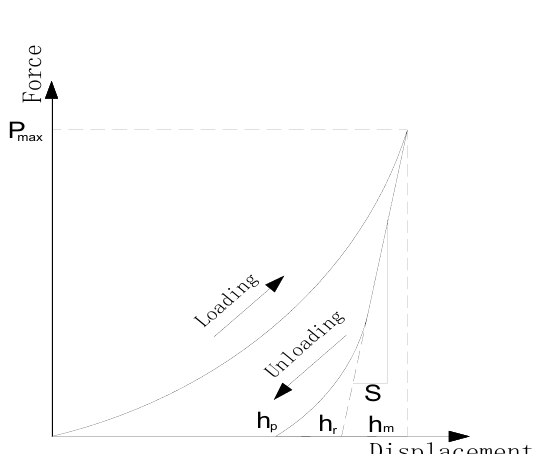
Figure 2. Micron indentation testing system.